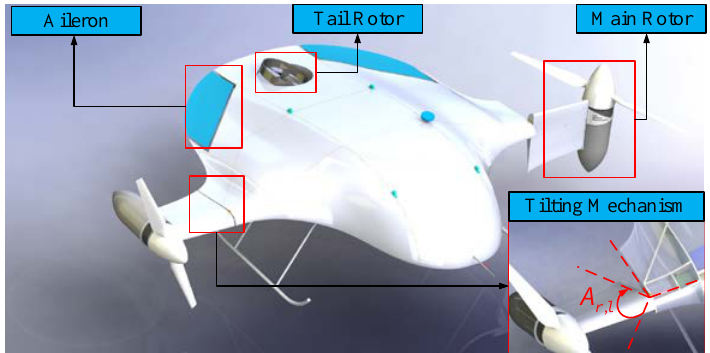
Figure 1. The structural platform of the